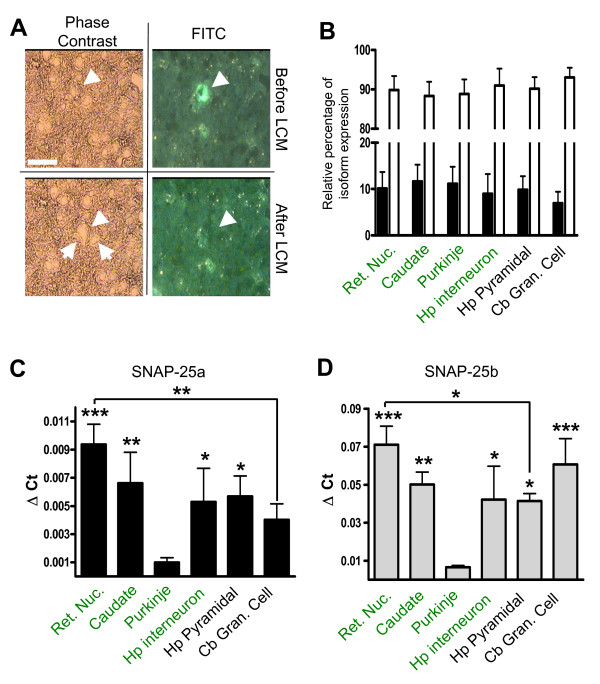
SNAP-25 isoform expression varies between anatomical regions of the adult brain. GFP-expressing cells from coronal sections of adult (P50) transgenic GAD67-GFP (ΔNeo) mouse brains were identified by epifluorescence and isolated by laser capture microdissection (LCM) from the reticular nucleus of the thalamus (Ret. Nuc.), caudate, cerebellum (Purkinje cells), and CA1 region of the hippocampus (Hp interneuron). In addition non-GFP expressing glutamatergic neurons collected from the pyramidal layer of the hippocampus (Hp Pyramidal) and granule layer of cerebellum (Cb Gran. Cell). The total RNA extracted from microdissected samples was assayed by real-time qRT-PCR analysis to assess transcript levels relative to β-actin as a control gene, as described in the Methods. Panel A is a representative micrograph of a GFP-expressing cell (arrowhead and hashed outline) before and after LCM, visualized with both phase contrast (left) and a FITC filter set (right). Note how neighboring cells (arrows) and tissue remain intact during the procedure. B, Histogram shows the relative ratio of SNAP-25a (solid bar) and 25b (white bar) RNA expression in selected brain regions (n = 6 pools taken from individual brains). Note that although, in all cases, SNAP-25b expression is significantly higher than SNAP-25a (***P < 0.001, Student's t-test), the ratio of isoform expression between anatomical regions does not change (n. s.; One-way ANOVA with Tukey post hoc comparison). Throughout the areas surveyed, however, the overall mRNA expression of SNAP-25a and SNAP-25b did vary widely (shown in Panels C and D, respectively). Statistical analysis with a one-way ANOVA and Tukey post hoc comparisons of total SNAP-25a and SNAP-25b transcript expression was carried out for each anatomical region (n = 3, except for cerebellar granule cells, n = 6). Asterisks denote significance of the difference between the level of SNAP-25 transcripts of each region compared to cerebellar Purkinje cells (* = p < 0.05; ** = p < 0.01; *** = p < 0.001); additional significant differences in isoform transcripts between GABAergic neurons of the reticular nucleus (Ret. Nuc.) and non-GABAergic neurons of the hippocampus (Hp Pyramidal) and cerebellum (Cb Gran. Cell) are also indicated.